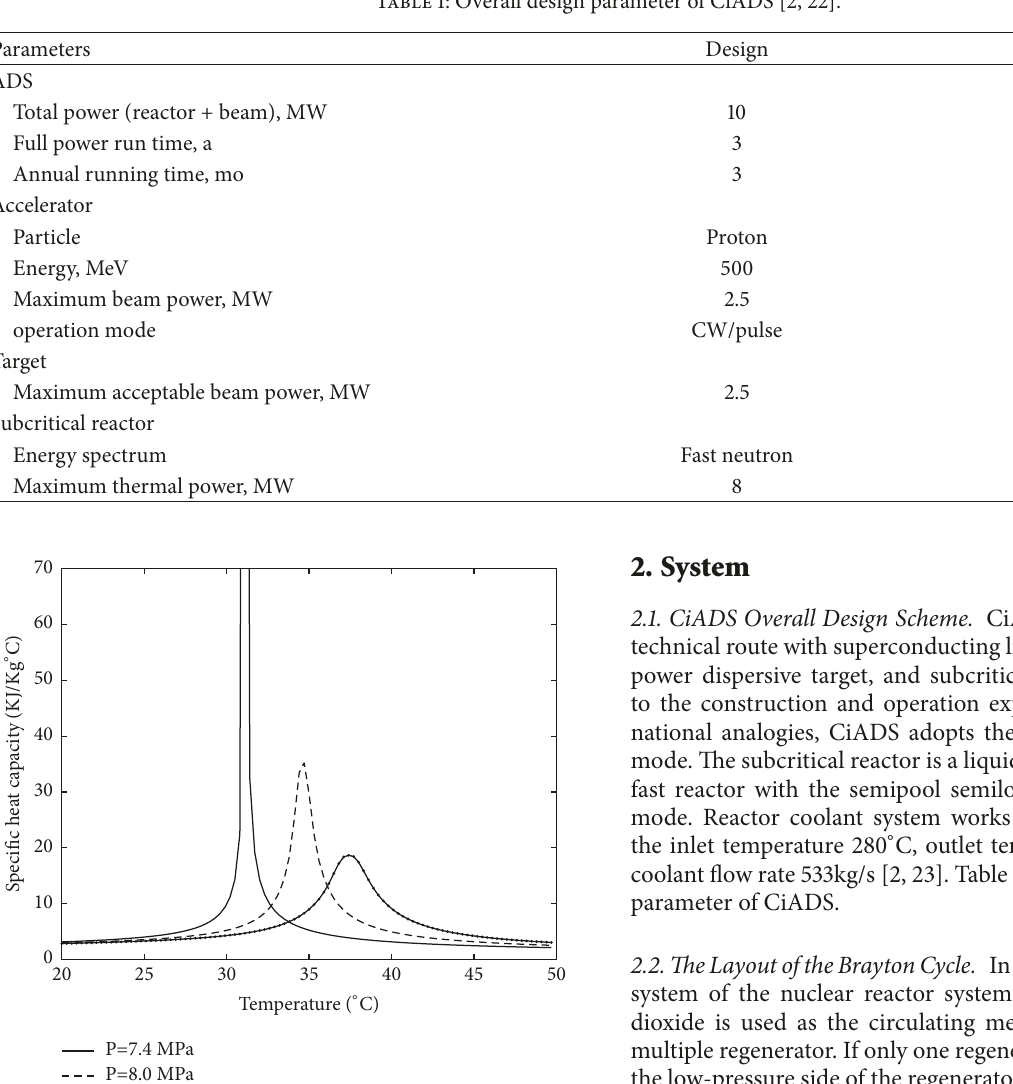
Table 1: Overall design parameter of CiADS [2, 22].